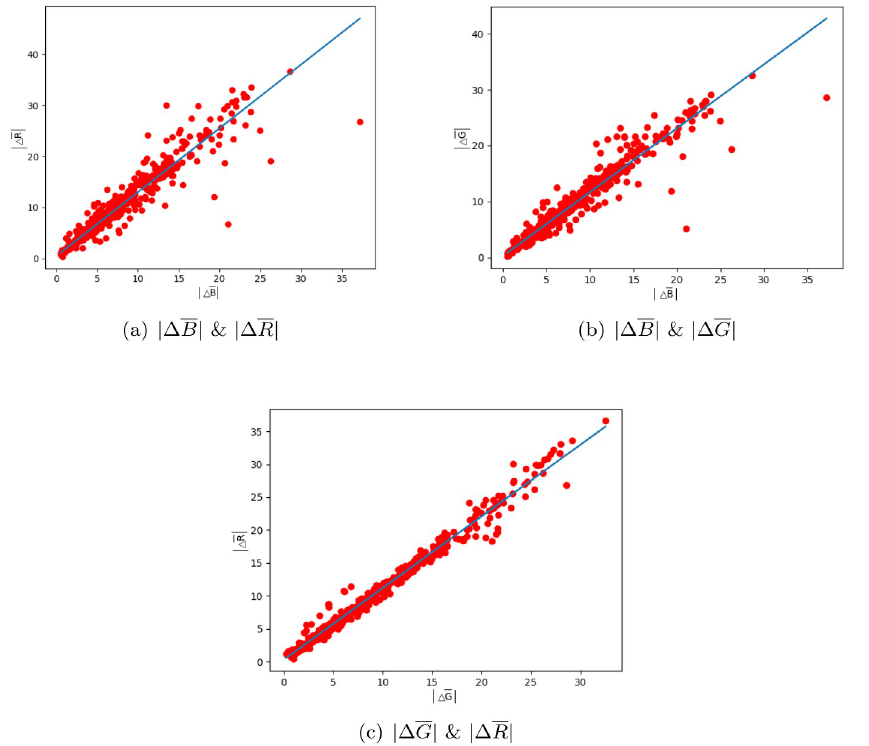
Fig 2. The relationships of j D � R j , j D � G j and j D � B j . (a) j D � B j & j D � R j . (b) j D � B j & j D � G j . (c) j D � G j & j D � R j